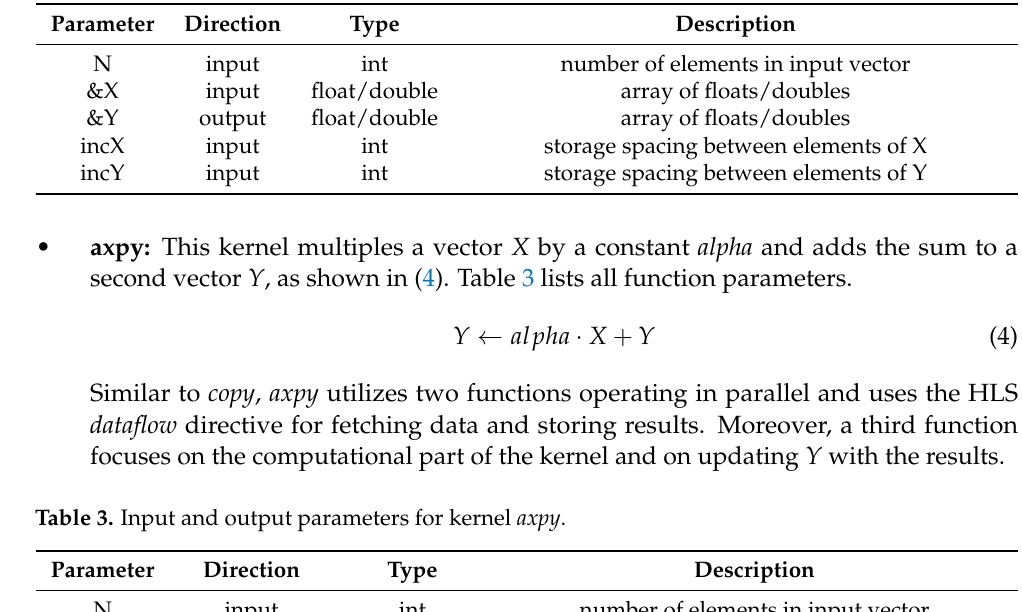
Table 2. Input and output parameters for kernel copy .